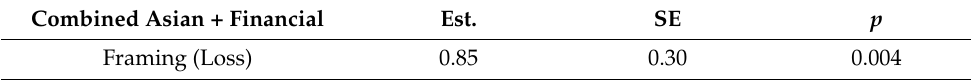
Table 6. Regression model, Asian disease and Financial crisis